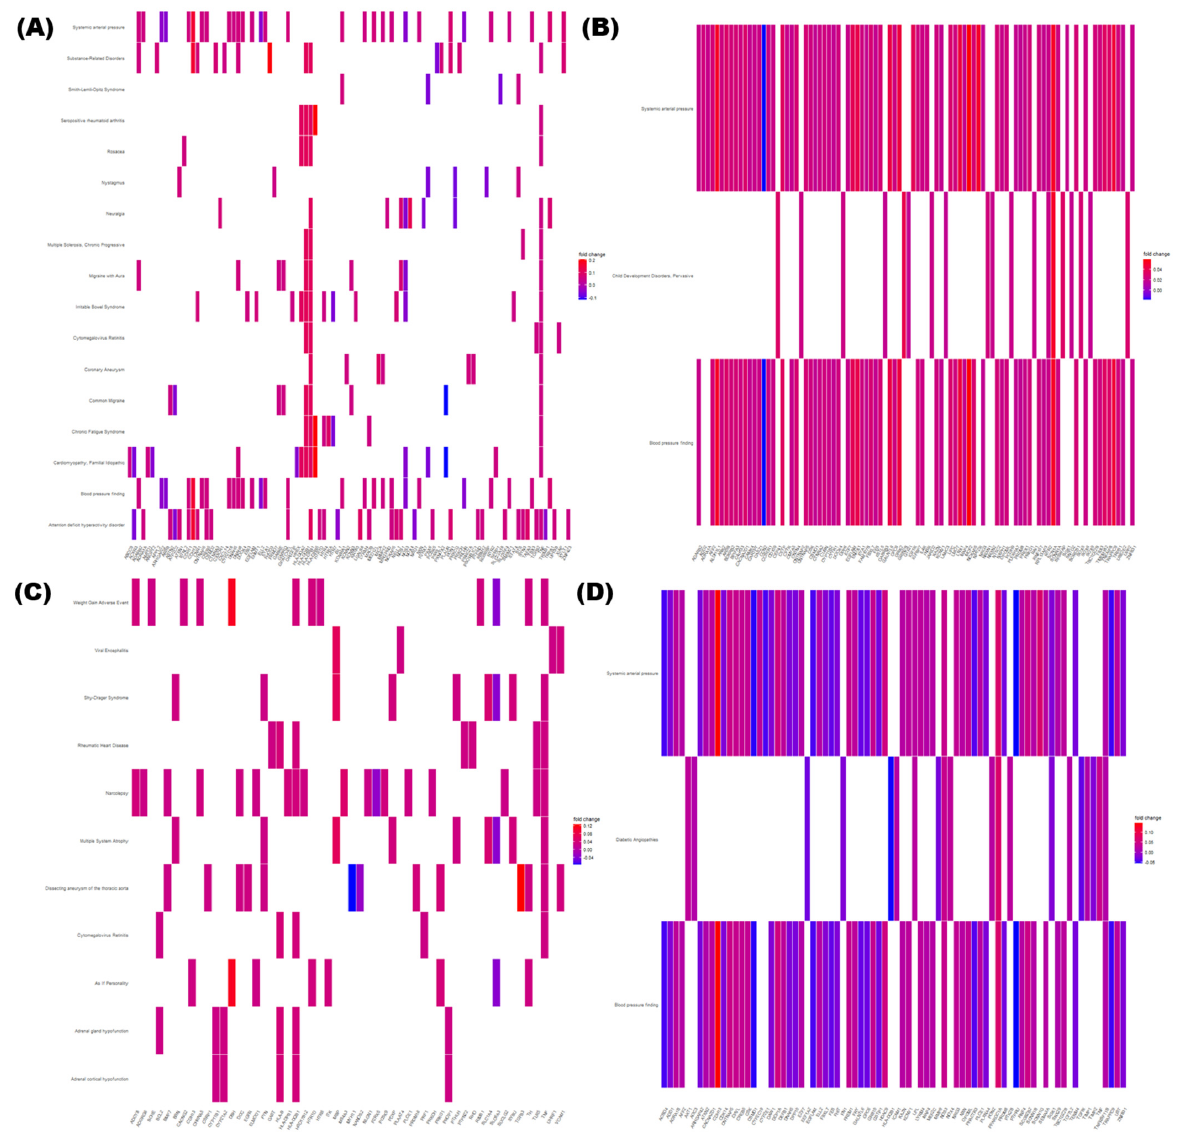
Figure 6. Gene-concept heatmap of the DMRs indicating the difference between four pairs of the four groups. The X -axis represents each gene, and the Y -axis represents the terms corresponding to each gene. Color ranges from red (high methylated in drinkers) to blue (high methylated in non-drinkers). ( A ) In females with chronic cardiovascular diseases (CVDs), the pairs of 9 drinkers versus 36 non-drinkers were included in the enrichment test, and each term satisfying the criteria |fold change| > 0.08 and p -value < 0.05 was retrieved. ( B ) In males with CVD, the pairs of 15 drinkers versus 15 non-drinkers were included in the enrichment test, and each term satisfying the criteria |fold change| > 0.08 and p -value < 0.05 was retrieved. ( C ) In females with non-CVD, the pairs of 42 drinkers versus 123 non-drinkers were subjected to the enrichment test, and each term satisfying the criteria |fold change| > 0.04 and p -value < 0.05 was retrieved. ( D ) In males with non-CVD, the pairs of 136 drinkers versus 47 non-drinkers were subjected to the enrichment test, and each term satisfying the criteria |fold change| > 0.04 and p -value < 0.05 was